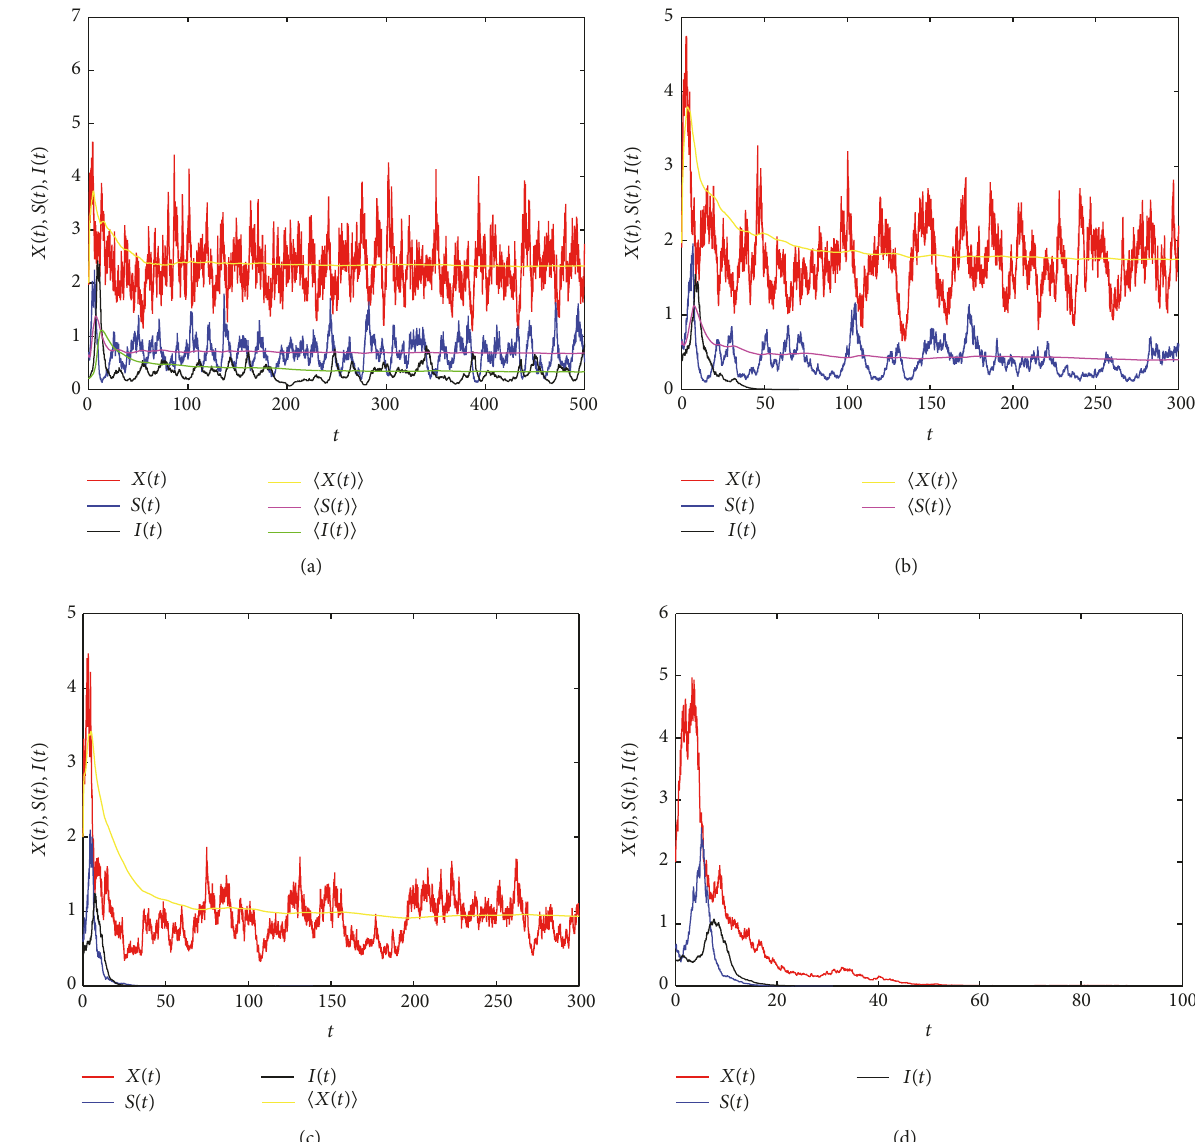
Figure 3: Keep 𝛾 1 = 0.5 , 𝛾 2 = 0.5 , 𝛾 3 = 0.1 , and 𝑢 = 0.4 . In (a), 𝑇 = 1 , 𝑋(𝑡) , 𝑆(𝑡) and 𝐼(𝑡) are permanent, lim 𝑡→∞ ⟨𝑋(𝑡)⟩ = 2.072 , lim 𝑡→∞ ⟨𝑆(𝑡)⟩ = 0.680 , and lim 𝑡→∞ ⟨𝐼(𝑡)⟩ = 0.345 ; in (b), 𝑇 = 0.7 , 𝑋(𝑡) and 𝑆(𝑡) are permanent, 𝐼(𝑡) is extinct, lim 𝑡→∞ ⟨𝑋(𝑡)⟩ = 1.743 , and lim 𝑡→∞ ⟨𝑆(𝑡)⟩ = 0.386 ; in (c), 𝑇 = 0.5 , 𝑋(𝑡) is permanent, 𝑆(𝑡) and 𝐼(𝑡) are extinct, and lim 𝑡→∞ ⟨𝑋(𝑡)⟩ = 0.952 ; in (d), 𝑢 = 0.4 and then the species are